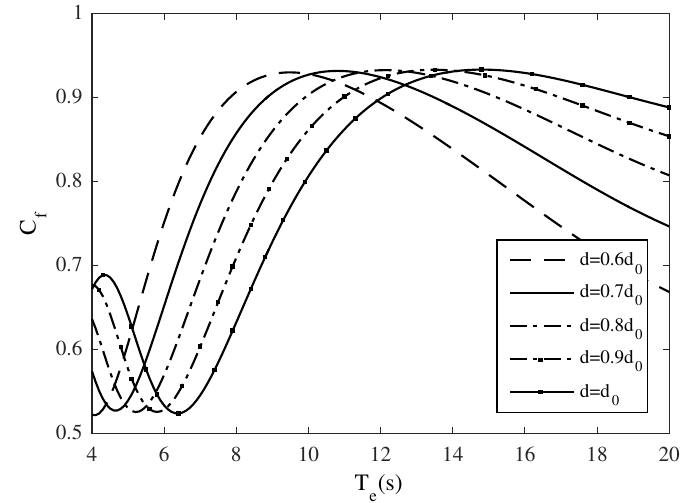
Figure 17. C f for different chamber lengths ( d ) in the optimal control condition with T e (s).